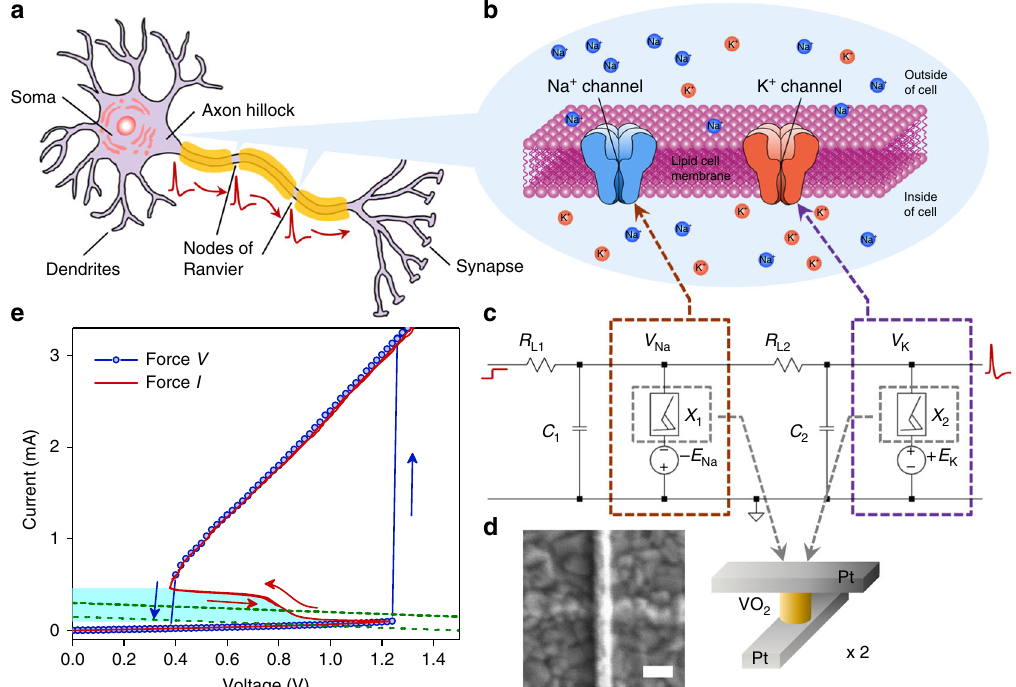
Fig. 1 Circuit diagram of a biomimetic active memristor neuron and active memristor device characteristics. a Schematic structure of a biological neuron, showing that an action potential is fi red near the axon hillock (under suf fi cient input stimulus) and propagates along the cell axon towards the output synapses. b Mechanism of voltage-gated Na + and K + ion fl ows across the cell membrane that accounts for the action potential generation and repetition across the nodes of Ranvier (myelin-sheath gaps). A similar mechanism exists in neurons that lack a myelin sheath. c Basic circuit topology of a two- channel active memristor neuron to emulate the neuronal dynamics in ( b ). A voltage-gated Na + (K + ) channel is emulated by a negatively (positively) d.c. biased active memristor device, which is closely coupled with a local membrane capacitor C 1 ( C 2 ) and a series load resistor R L1 ( R L2 ). d Schematic structure and a scanning electron micrograph of a typical VO 2 active memristor nano-crossbar device ( X 1 or X 2 in ( c )). Scale bar: 100 nm. e Typical two-terminal quasi d.c. voltage-controlled (force V ) and current-controlled (force I ) I – V characteristics of a VO 2 active memristor device. A wide hysteresis loop exists in the voltage-controlled mode due to the Mott transitions (blue arrows). The same Mott transitions are manifested by an “ S ” shaped negative differential resistance (NDR) regime (highlighted by cyan color) with a much narrower hysteresis (red arrows) in the current-controlled mode. In its resting state, the resistor load line for memristor X 1 (or X 2 ) intersects with its I – V loci outside the NDR regime (green dotted line). An input current or voltage stimulus can shift the load line into the NDR regime (green dashed line) and elicit an action potential generation